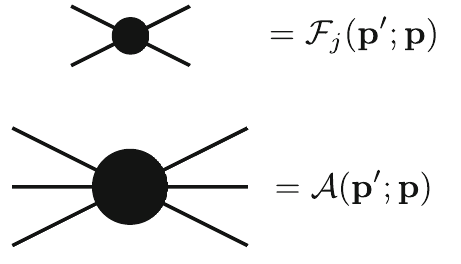
Fig. 1 Diagrammaticrepresentationofthedisconnected 2 → 2 ampli- tude of Eq. (3) (black disk with four external legs) and connected 3 → 3 amplitude of Eq. (2) (black disk with six external legs)